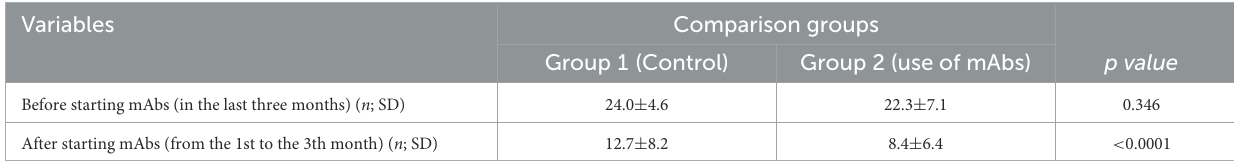
TABLE 3 Number of headache days before and after starting monoclonal antibodies.